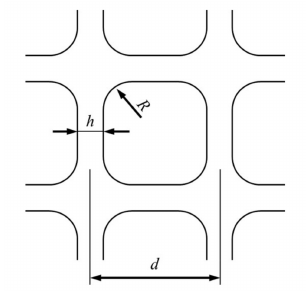
Figure 3. Schematic diagram of pore structure of